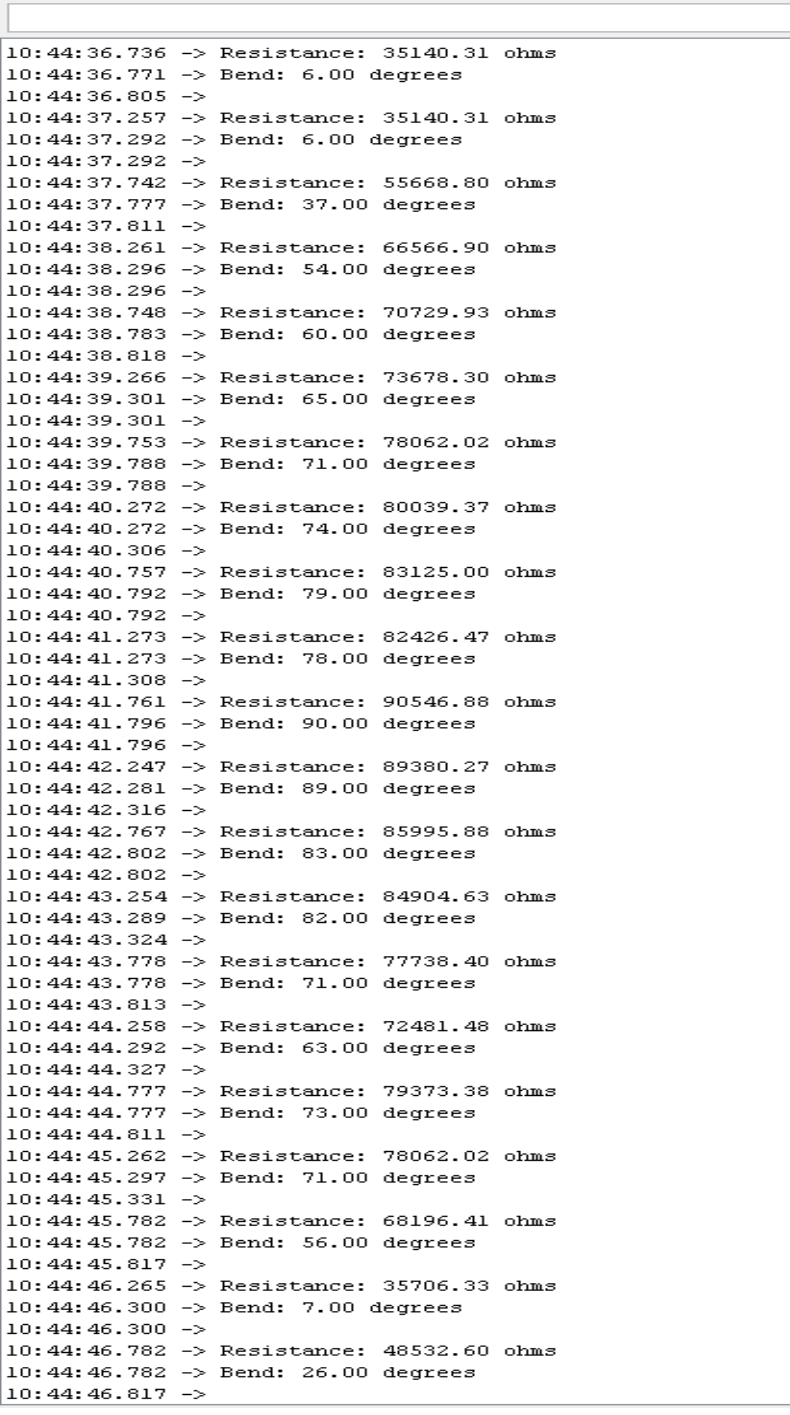
Figure A4. Application software for tilt angle measurement.